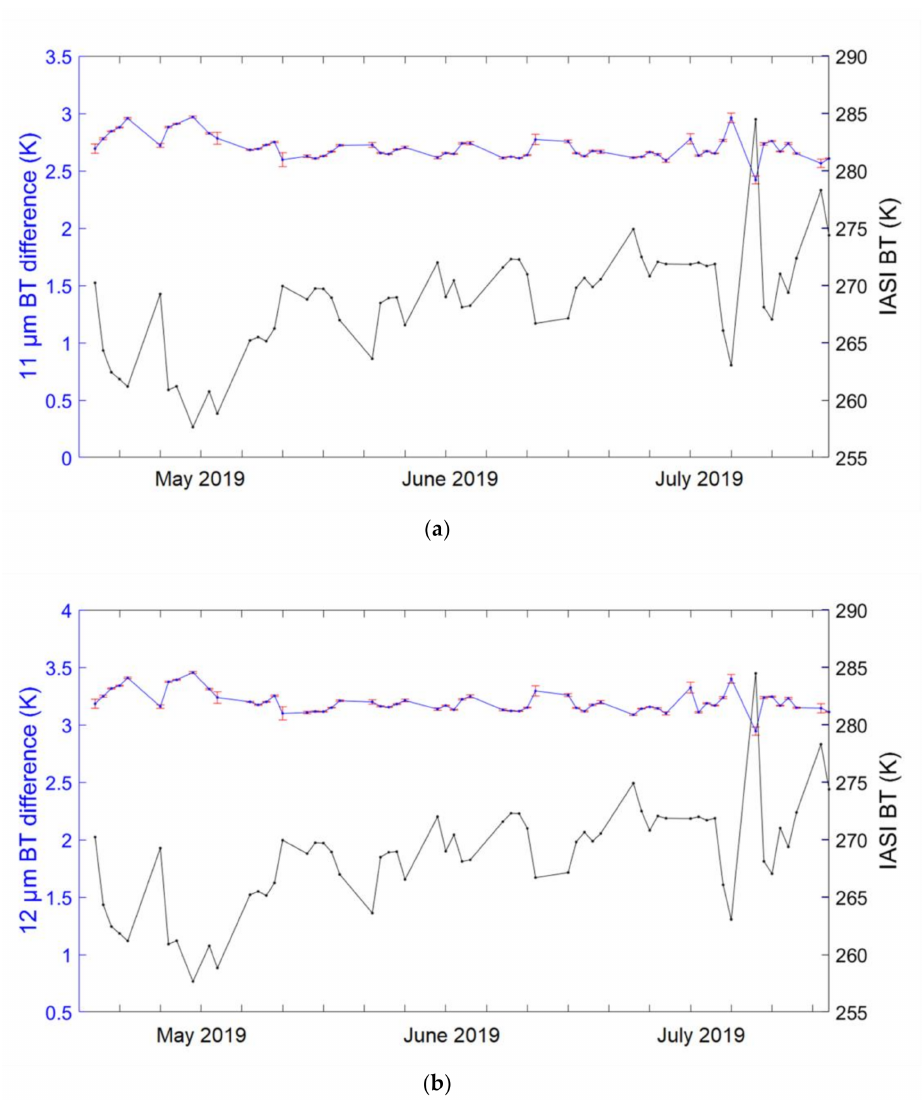
Figure 7. The time series plot of the BT difference between COCTS and IASI from May to July 2019 for the ( a ) 11 and ( b ) 12 µ m channels. The upper blue lines show the variations in the daily mean differences, accompanied with the red vertical bars indicating the daily uncertainties in the mean, corresponding to the left y -axis. The lower black lines represent the mean values of the IASI daily BTs corresponding to the right y